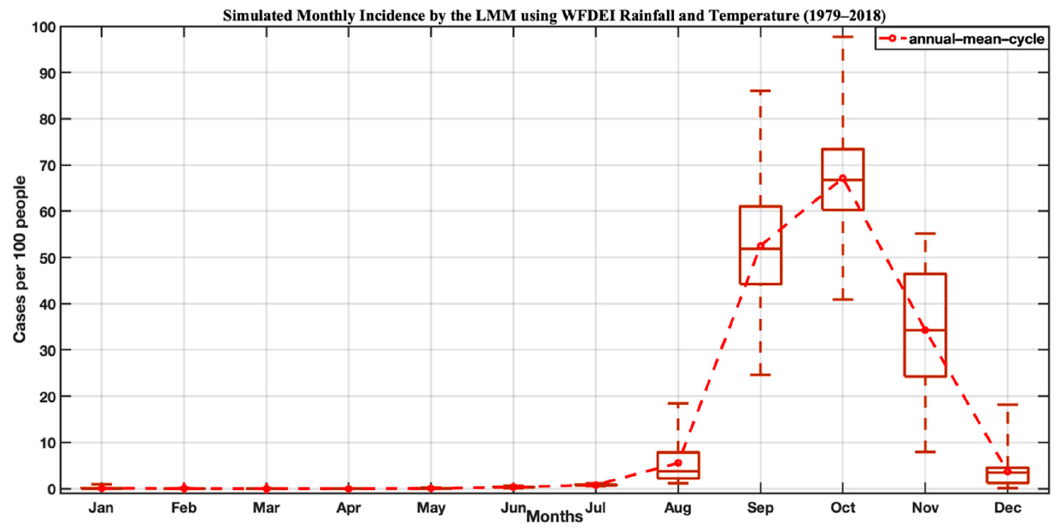
Figure 9. Intra-annual variation in incidence for the period 1979–2018: LMM model simulations based on WFDEI data.